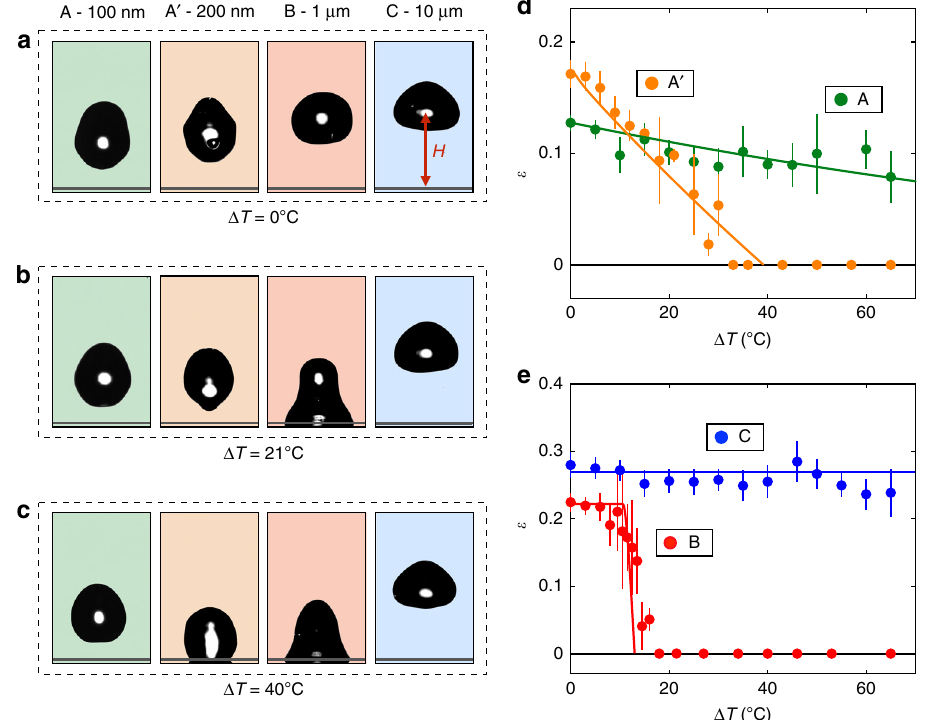
Fig. 2 Bouncing behaviour of hot drops. a – c Impacting water drops ( R = 1.4 mm and V = 40 cm s − 1 ) at their maximum bouncing height H for Δ T = 0°C ( a ), Δ T = 21 °C ( b ) and Δ T = 40 °C ( c ) on materials A, A ’ , B and C with respective pillar heights of about 100 nm, 200 nm, 1 µ m and 10 µ m. d , e Coef fi cient of restitution ε of the rebound as a function of the temperature difference Δ T between water and the solid surface ( R = 1.4 mm, V = 40 cm s − 1 ). For the sake of clarity, we separate data on nanometric features ( d ) from data on micrometric features ( e ). Water bounces on samples A and C at all drop temperatures, while it gets trapped ( ε = 0) on A ’ and B when Δ T exceeds ∼ 40 °C and ∼ 15 °C, respectively. Solid lines show equation (5). Error